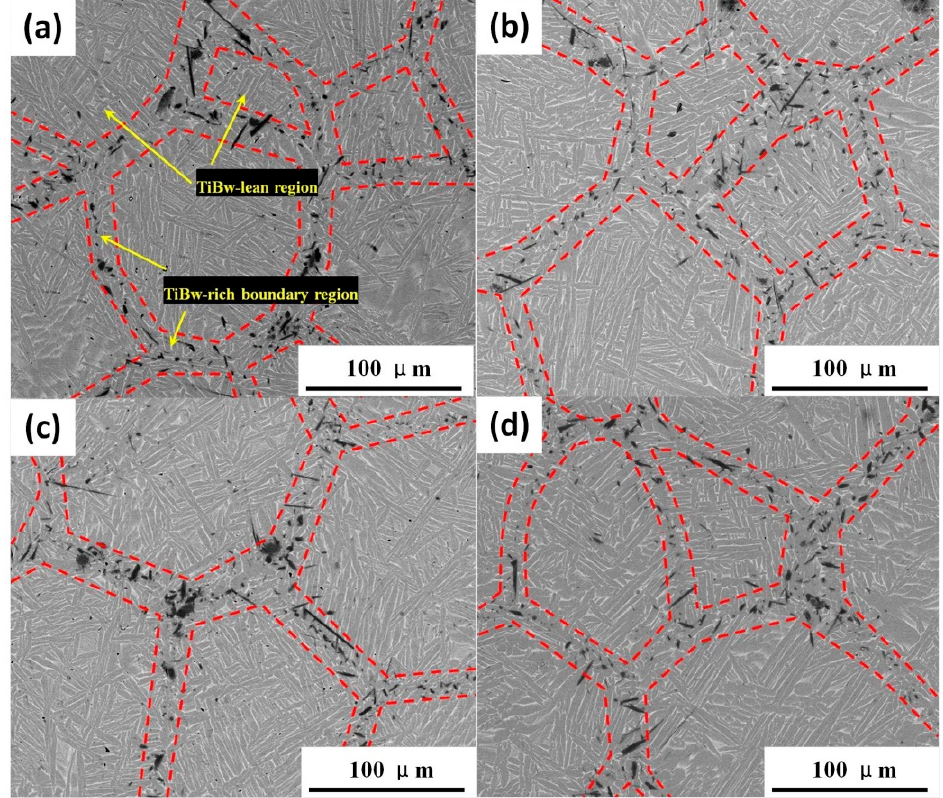
Figure 5. The typical SEM micrographs of the samples sintered at 1100 °C for different holding times: ( a ) 10 min; ( b ) 20 min; ( c ) 30 min; ( d ) 45 min.